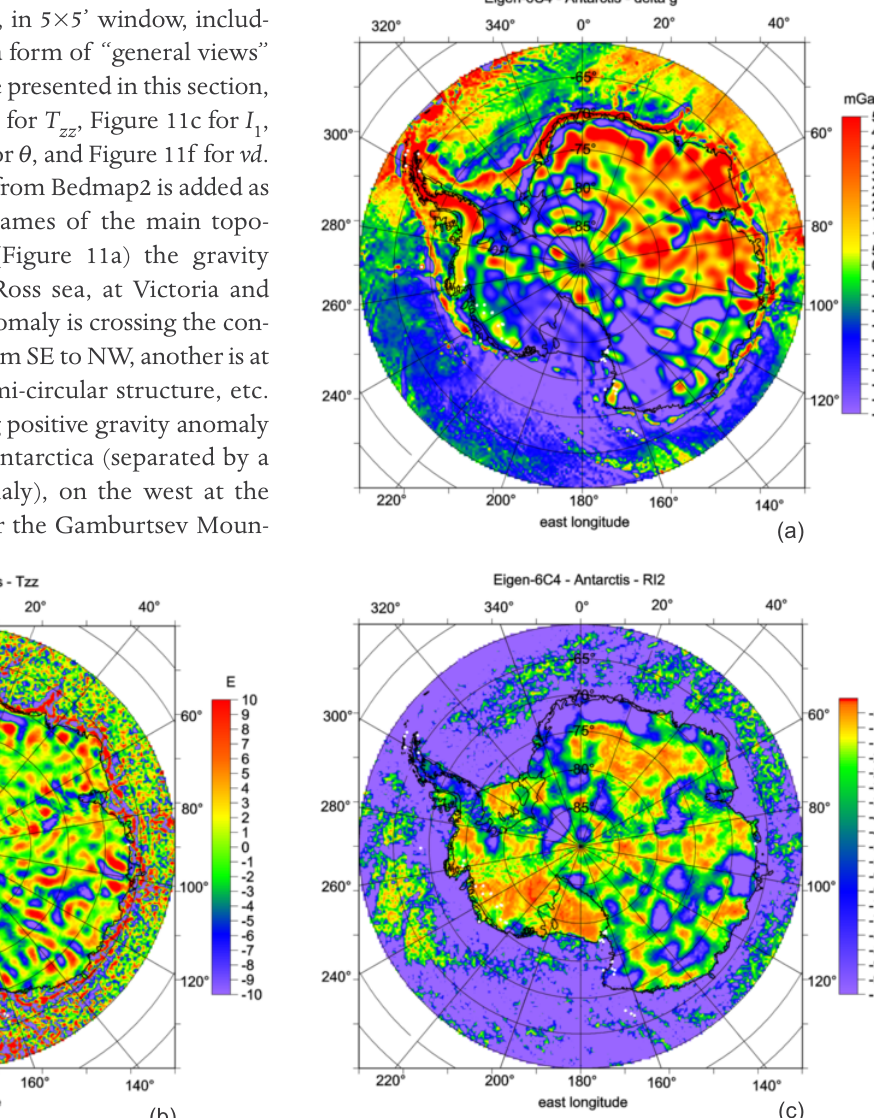
zz over Antarc- 1